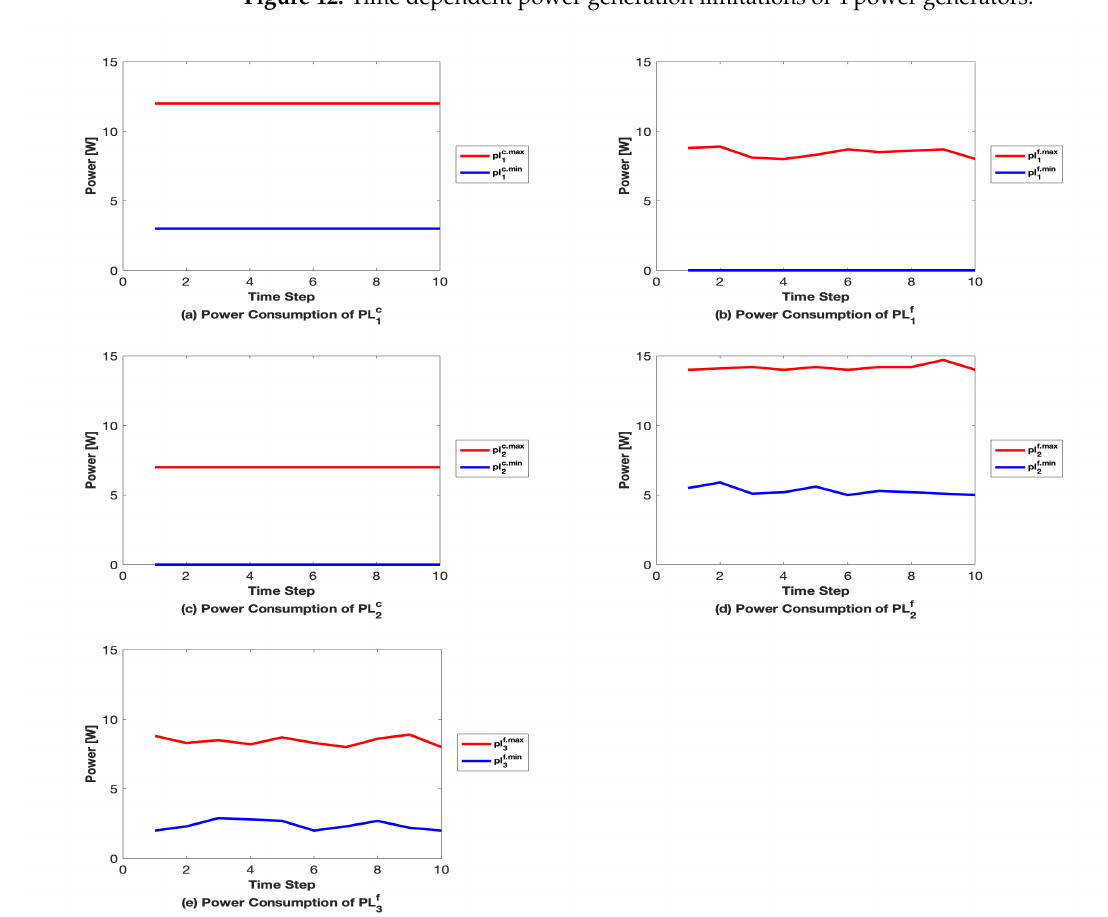
Figure 13. Time dependent power consumption limitations of 5 power